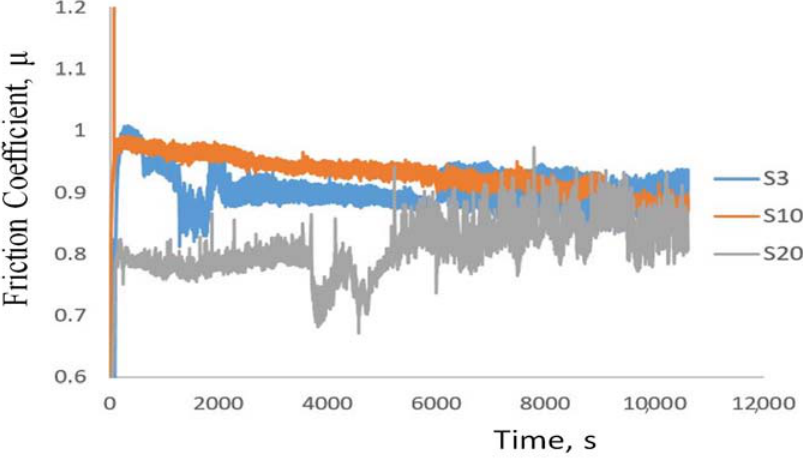
Figure 7. Friction coefficient of various sintered samples as function of time.